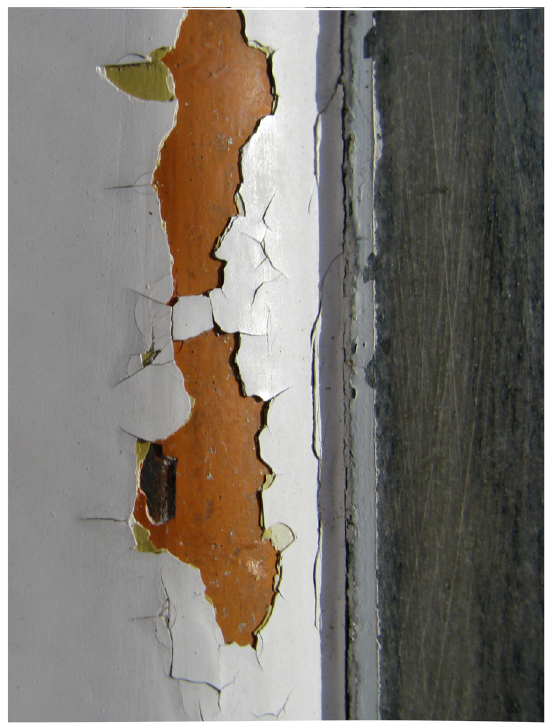
Fig. 18 Josef Frank and Oskar Wlach, Villa Beer in Vienna-Hietzing (1930), west facade, main entrance, metal door frame, detail with remains of the original ‘ Japanese red ’ paint (Source: